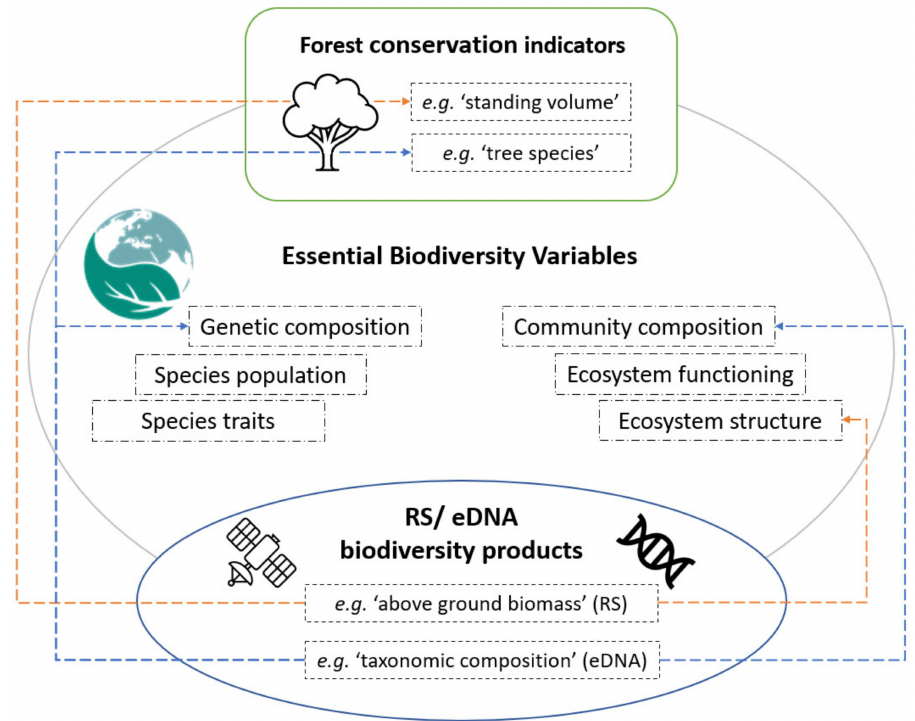
Figure 1. The three sets of examined variables, Essential Biodiversity Variables, forest conserva- tion indicators and remote sensing and environmental DNA biodiversity information products (RS/eDNA-products). For EBVs, the six classes that describe aspects of biodiversity are also shown. The arrows are examples of RS/eDNA products that can feed information to EBVs but can be used for policy reporting purposes as